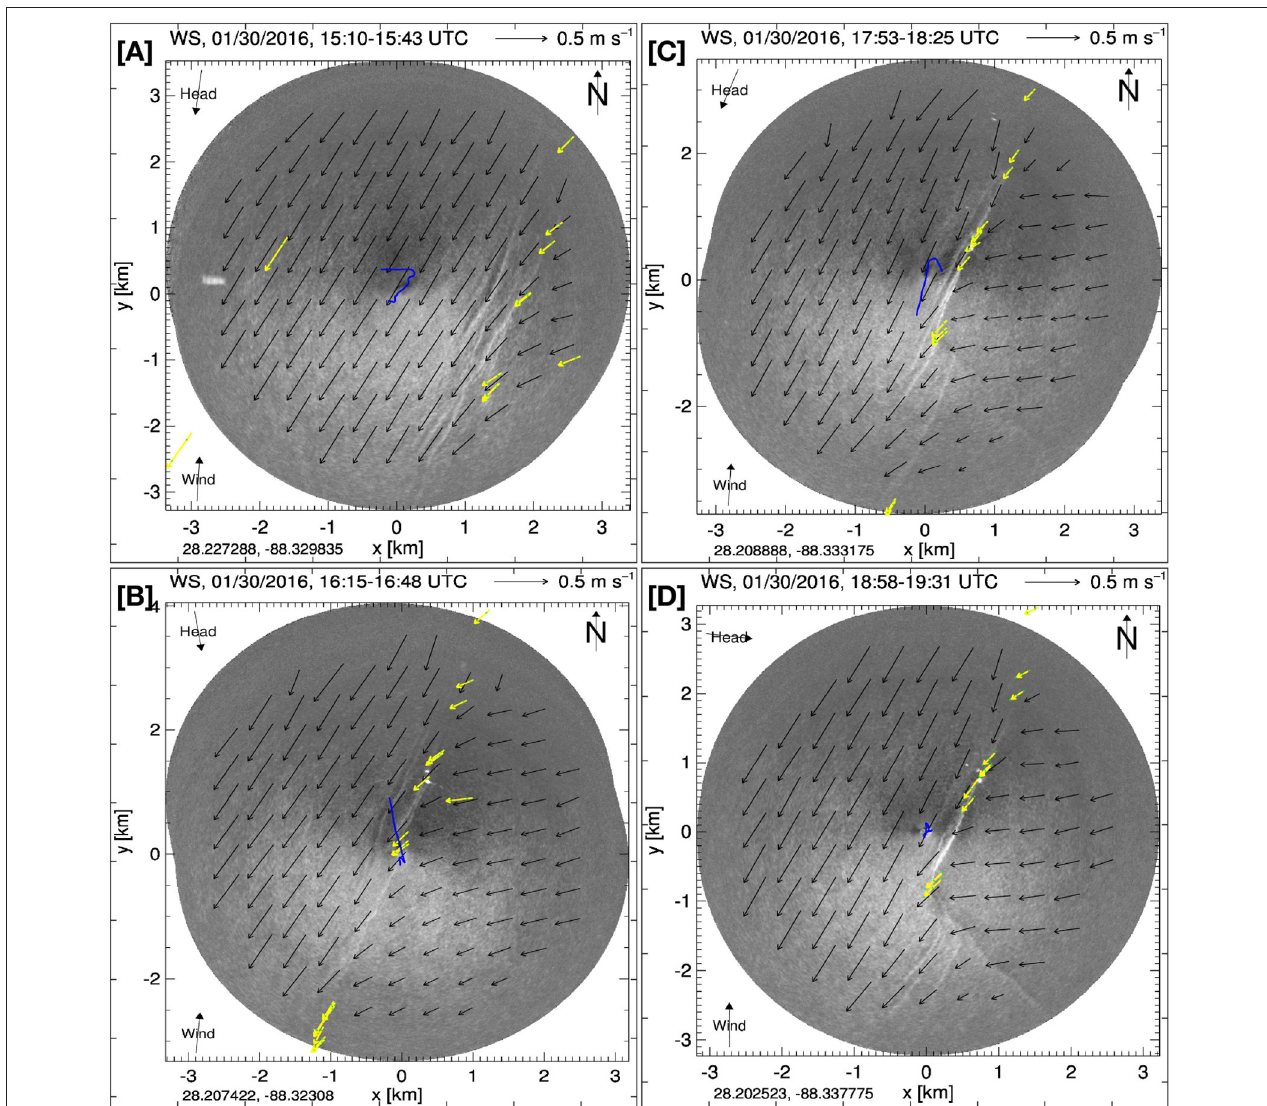
FIGURE 6 | A–D show the orientation of a density front that was targeted during the STARSS dispersion experiment on 30 January 2016. The front is visible in normalized marine backscatter intensity (greyscale; see section 2.3.4). Surface currents (black arrows), surface drifter trajectories (yellow arrows) and the ship track (blue) are also shown during the averaging period for each frame. The black arrows in the image corners indicate image heading, mean ship heading, and wind direction (counterclockwise from top right). (A) shows the front at approximately 30 min prior to the beginning of the STARSS experiment. The radar data shown in panels B–D correspond to times of 7 min, 105 min, and 170 min in Figures 9 – 12